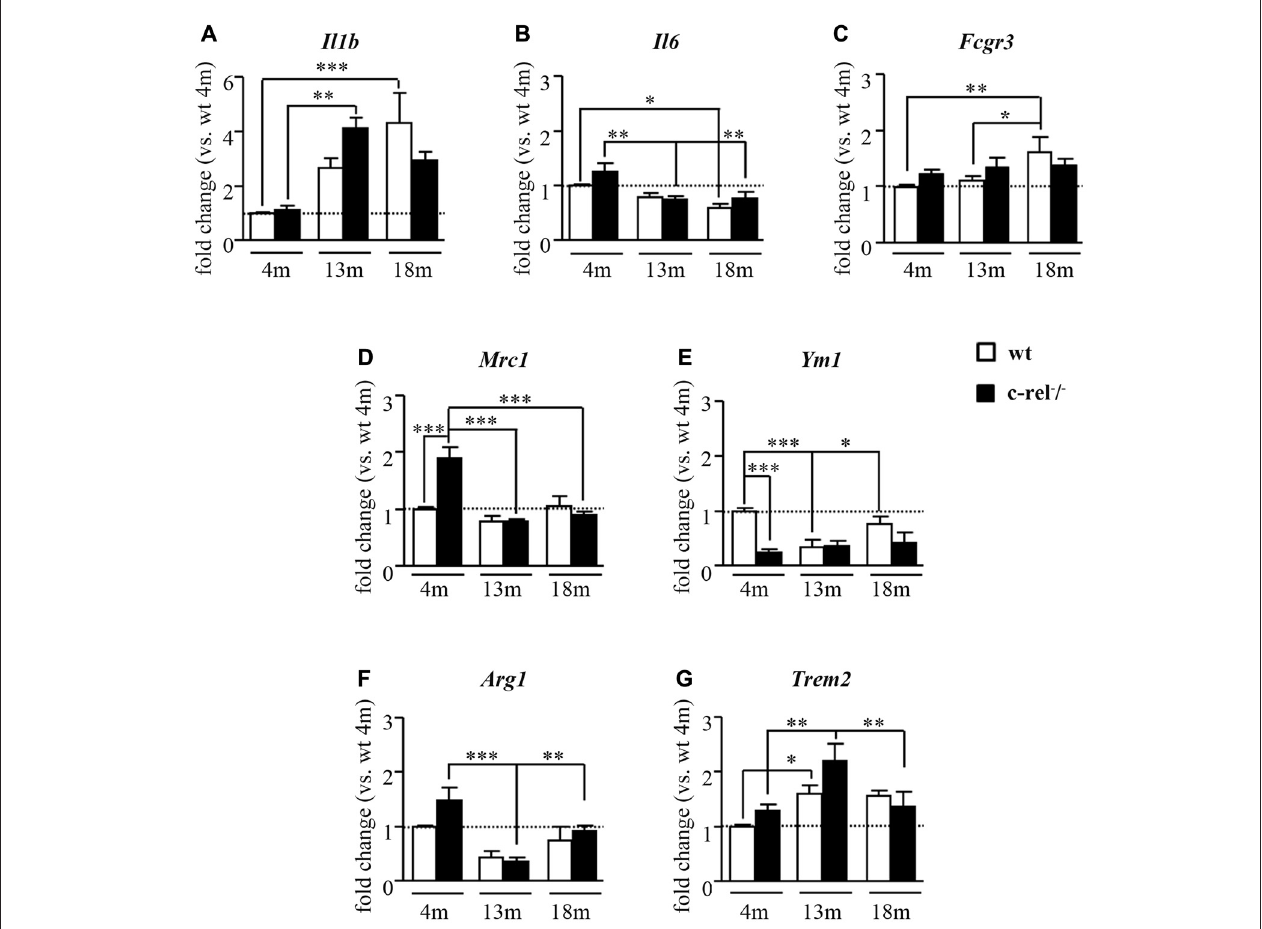
FIGURE 1 | Inflammatory and microglial/macrophage mRNA expression profile in c-rel − / − and wild-type (wt) mice. Real-time quantitative reverse transcription- polymerase chain reaction (qRT-PCR) analysis of pro-inflammatory cytokines, interleukin 1 beta ( Il1b ) and interleukin 6 ( Il6 ; A,B ), and microglial/macrophage activation markers, Fc gamma receptor III ( Fcgr3 ; C ), for M1 phenotype; mannose receptor 1 ( Mrc1 ; D ), chitinase-like 3 ( Ym1 ; E ), arginase 1 (Arg1) ; (F) , and triggering receptor expressed on myeloid cells 2 (Trem2) ; (G) , for M2 state in substantia nigra (SN) of 4, 13 and 18 months of age mice ( n = 4–6 animals per group). Four-month-old c-rel − / − mice showed increased expression of M2c microglial marker Mrc1 and Arg1 , associated with marked decrease of Ym1 transcription. At 13 months of age, c-Rel deficient mice displayed an upregulation in Il1b transcription compared to younger c-rel − / − mice, while no differences in microglial M2 markers were found in c-rel − / − mice compared to wt group. No biologically relevant variations in all the analyzed markers were evident in 18-month-old c-rel − / − mice compared to wt. Data are presented as mean ± SEM. ∗ P < 0.05, ∗∗ p < 0.01, ∗∗∗ p < 0.001; two-way analysis of variance (ANOVA) followed by Bonferroni test for comparison vs. 4-month-old wt